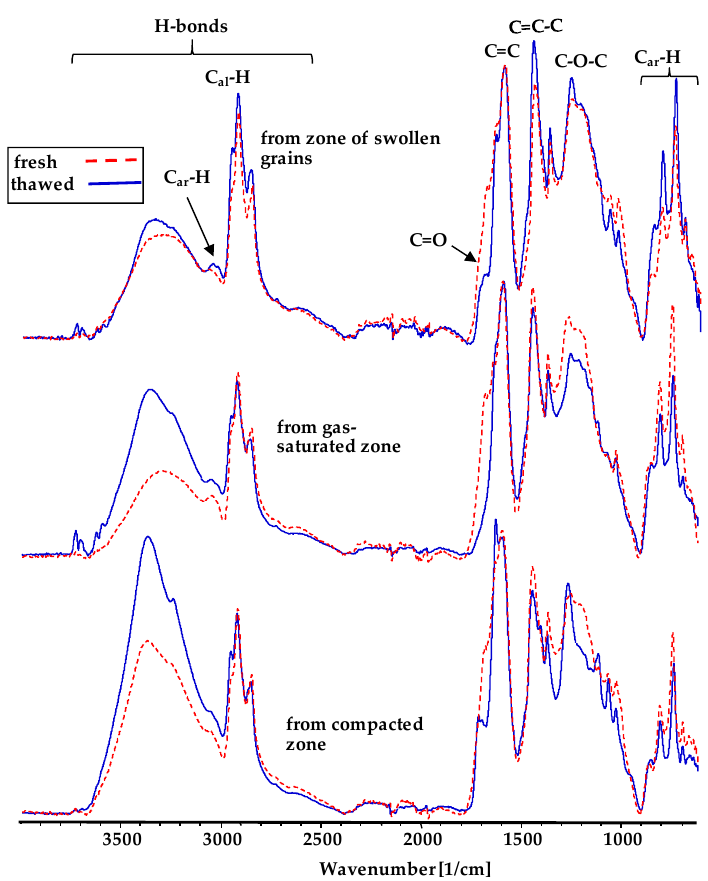
Figure 6. The Diffuse Reflectance Infrared Fourier Transform Spectroscopes (DRIFT) spectra of the material of the zones of plastic layer of fresh and thawed coals.